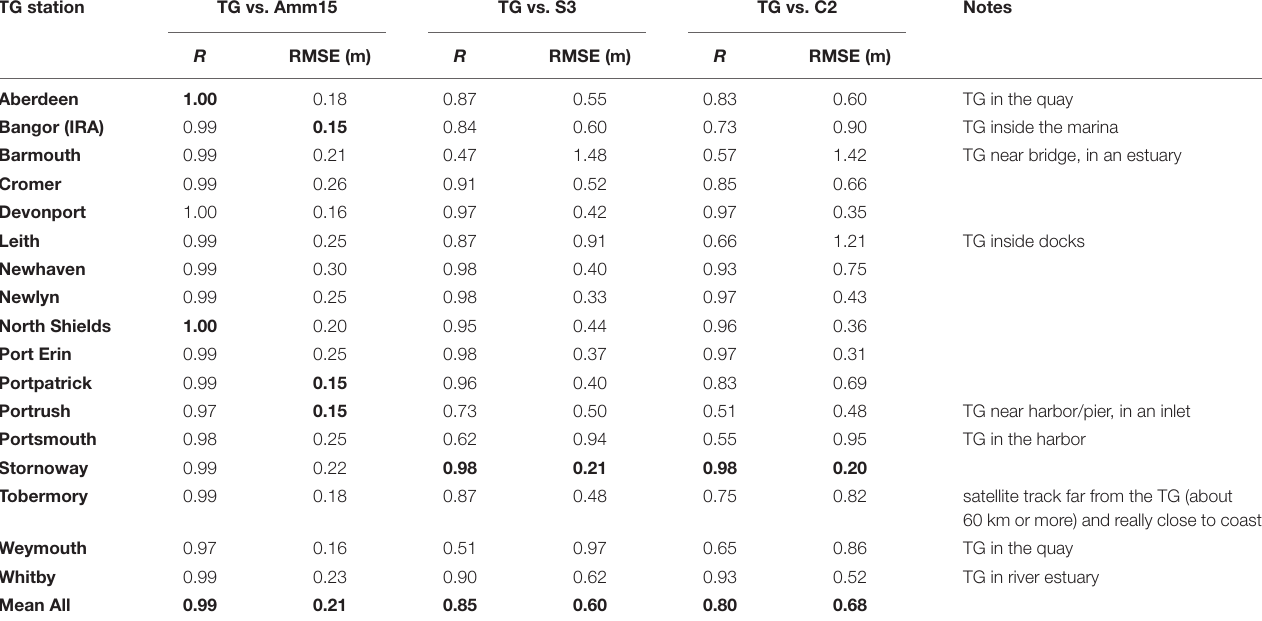
TABLE 1 | Comparison of model and satellites to tide gauges. TG